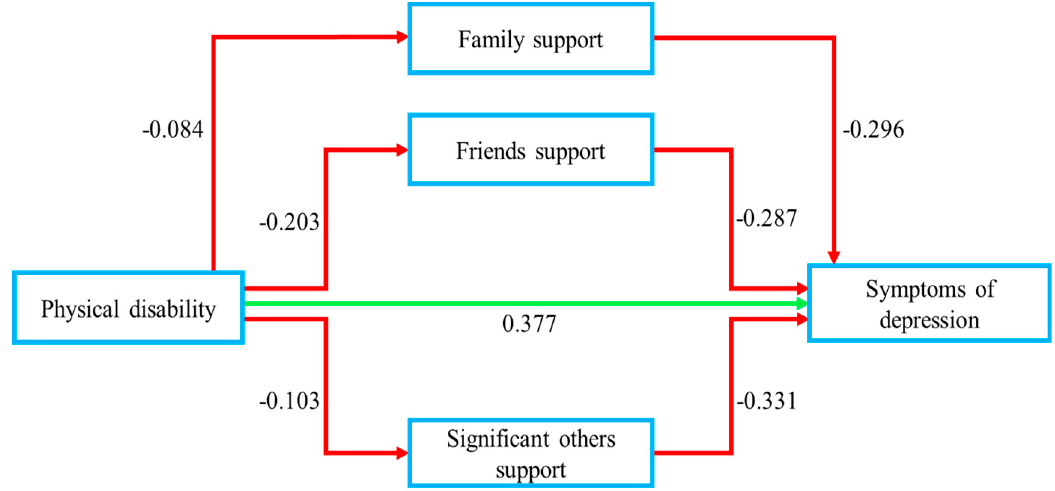
Figure 3. Mediating effect of perceived social support affecting physical disability and symptoms of depression among senior citizens of Pakistan ( N = 300).